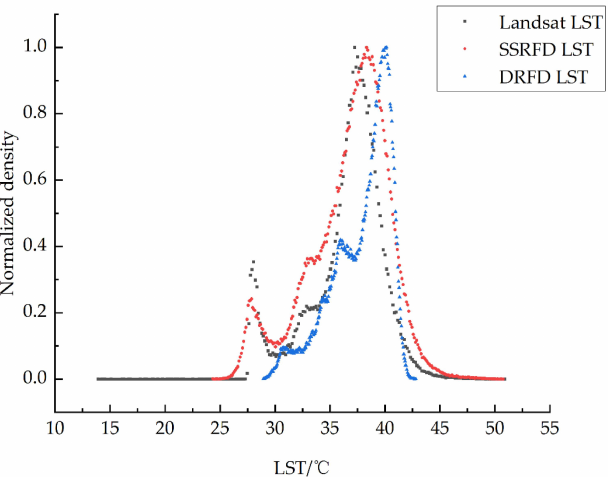
Figure 3. Histogram of downscaled LST and Landsat LST at 30-m resolution (black cubes refer to Landsat LST, red circles refer to downscaled LST obtained by the SSRFD method, blue triangles refer to downscaled LST obtained by the DRFD method).